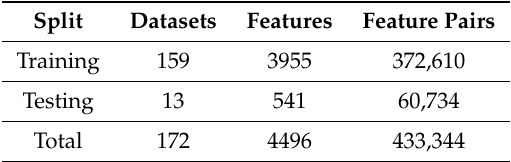
Table 1. Description of datasets used for correlation regression and feature generation.